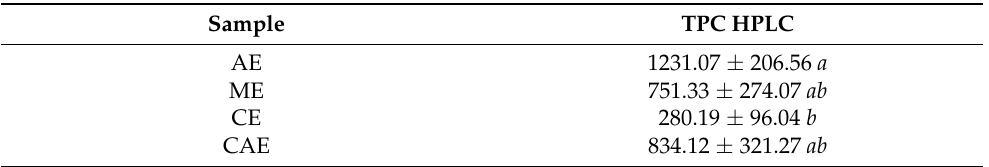
Table 4. Total polyphenol content of extracts. “AE” aqueous extract; “ME” methanolic extract; “CE” cake methanolic extract; “CAE” cake acetone extract. Results expressed in mg polyphenols/kg grape pomace. Different letters indicate significant difference ( p <